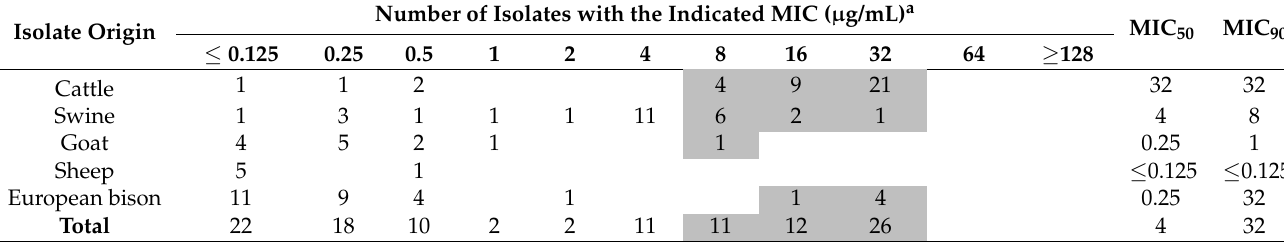
Table 1. Distribution of minimum inhibitory concentration (MIC) of tetracycline, MIC 50 and MIC 90 values for the studied Trueperella pyogenes isolates ( n = 114). Isolate